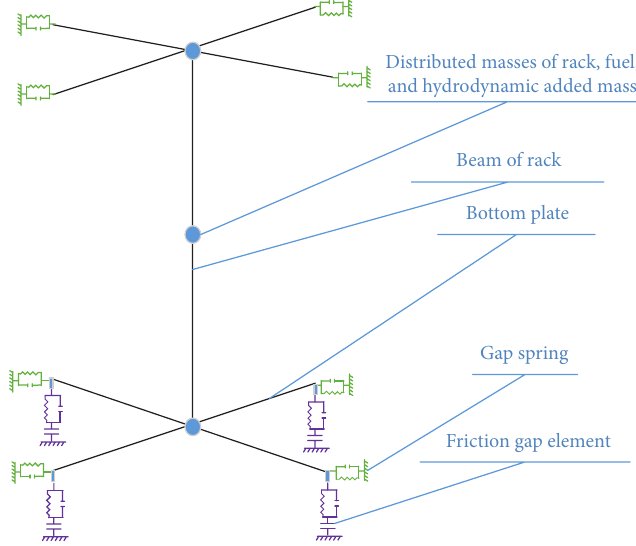
Figure 2: Model of free standing fuel rack.